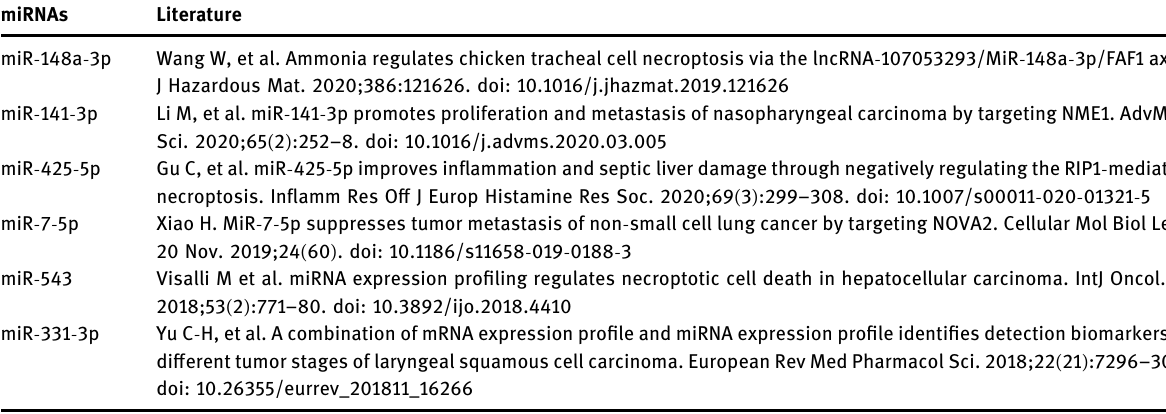
Table 1: Literature associated with the six necroptosis - related miRNAs miRNAs